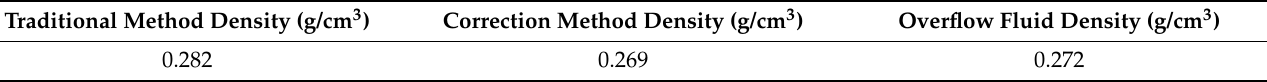
Table 6. The calculation results of Well C.